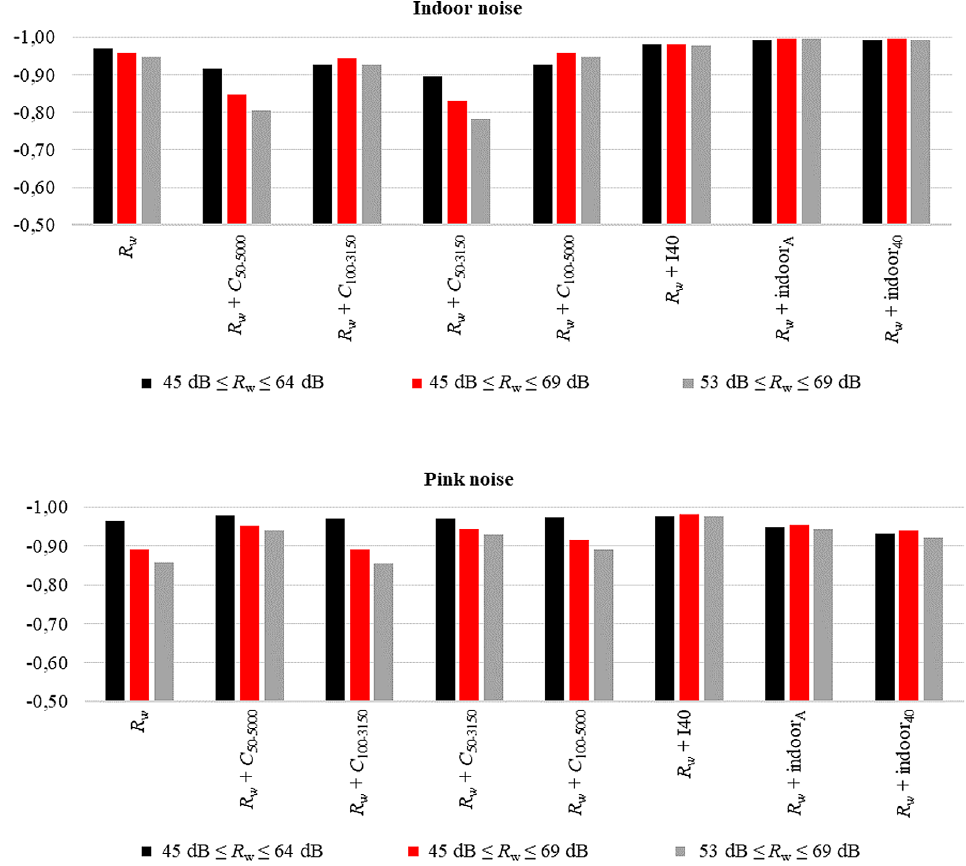
Figure 7. Degree of correlation between SNQ-ranking and transmitted loudness-based ranking, as quanti fi ed by Spearman ’ s rank- order correlation, based indoor noise (top) and on pink noise (bottom) as emitted sound. The closer SROC is to (cid:1) 1, the better the